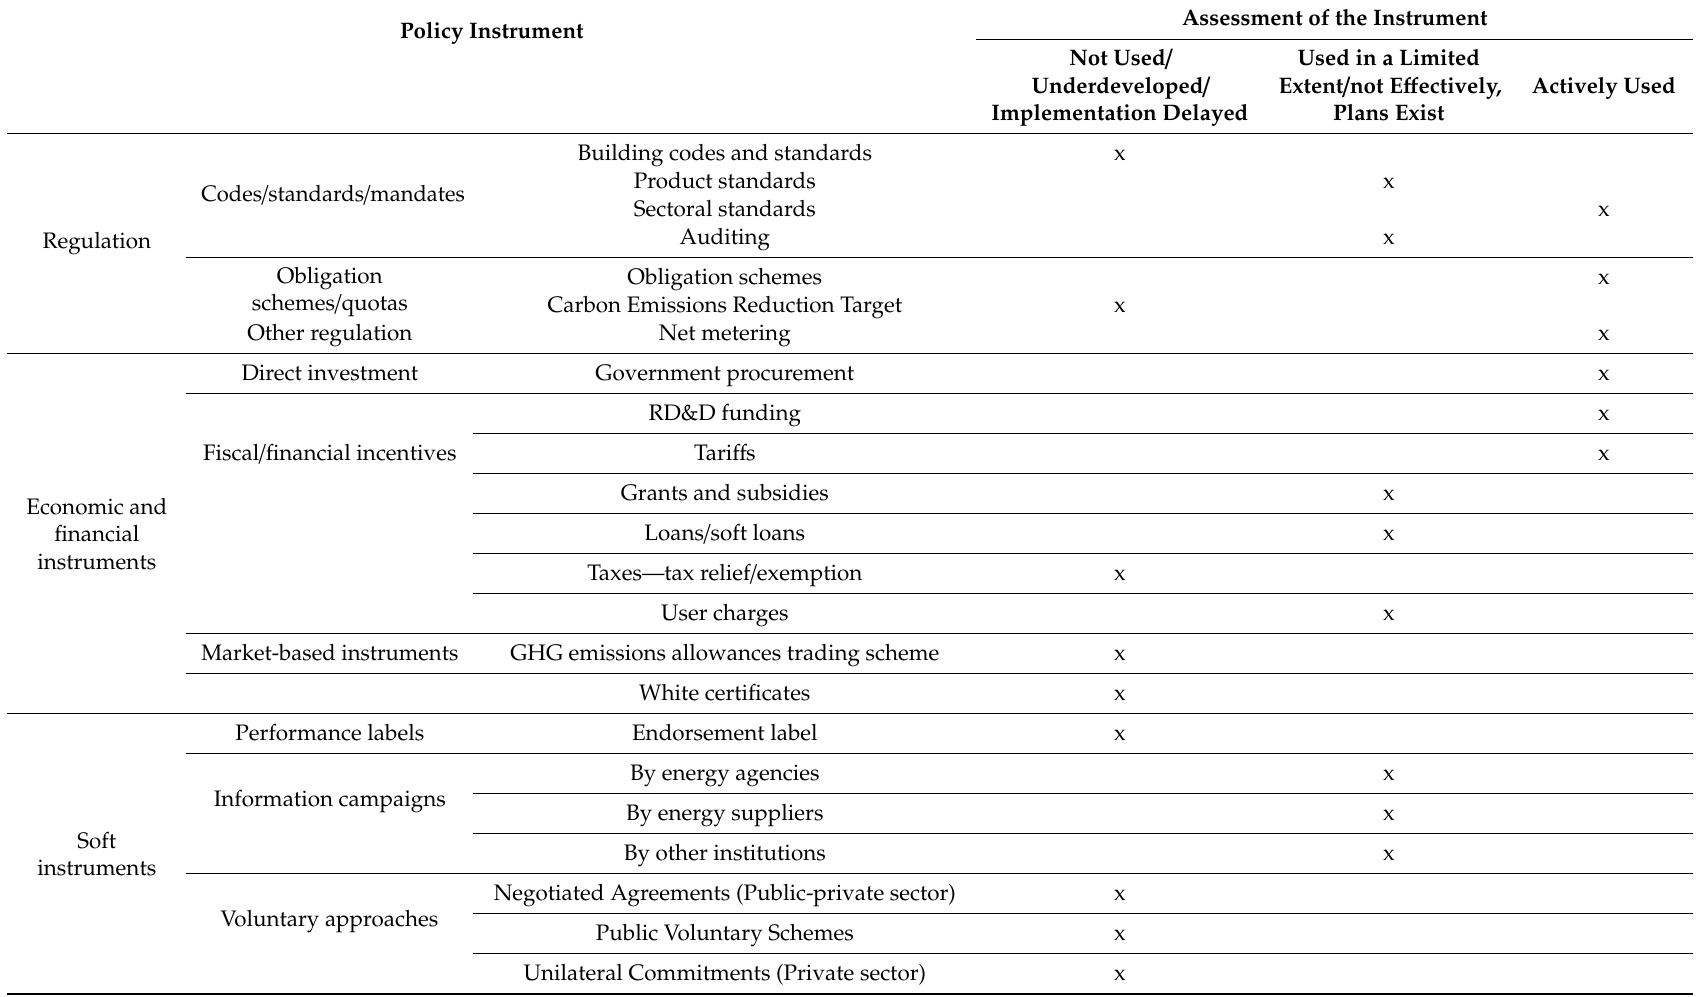
Table 3. Assessment of the EU-level policy instruments addressing smart metering Technology Innovation System (TIS) (source: Authors’ work, following classification of policy instruments developed by